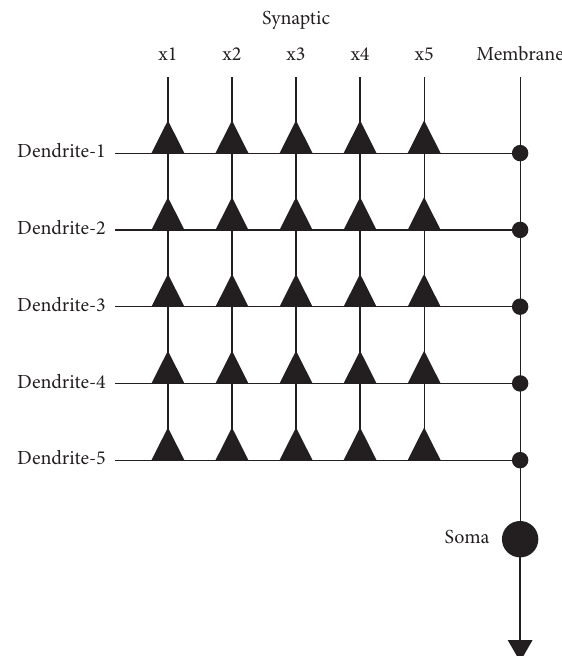
Figure 1: Architecture of